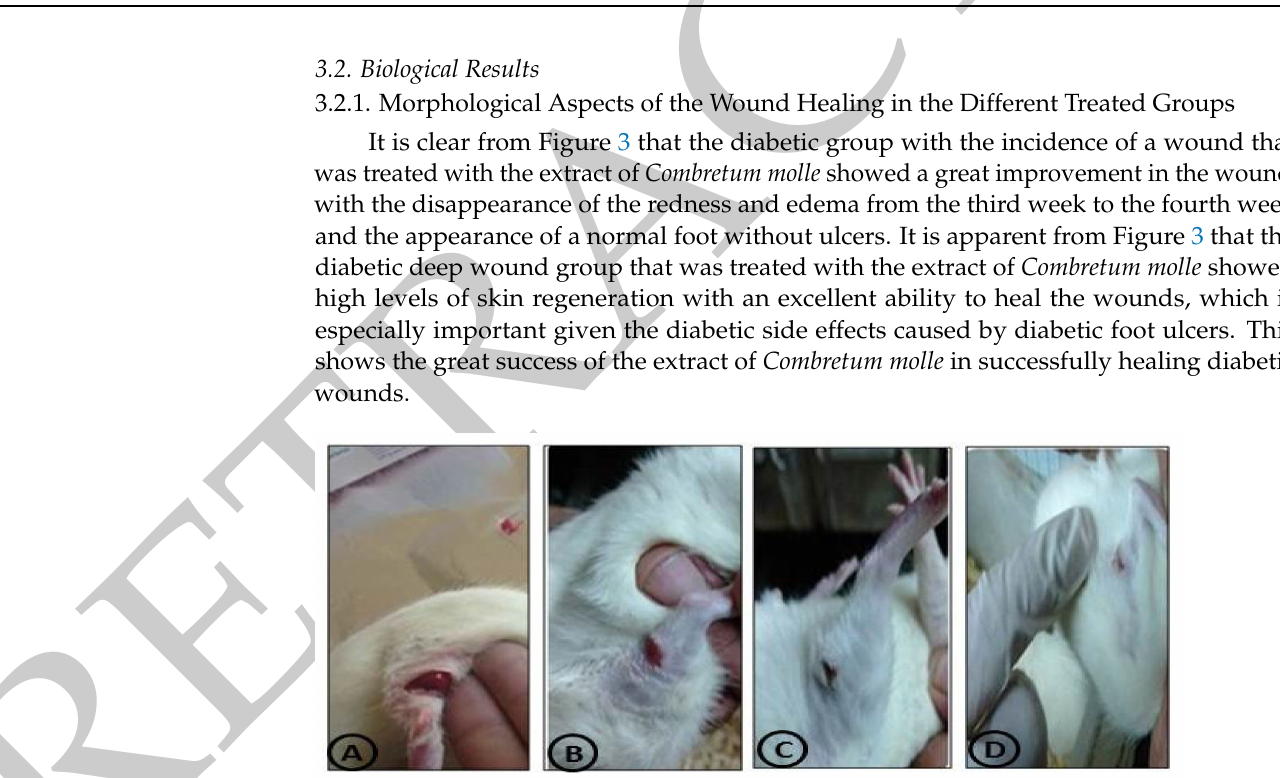
Figure 3. Variations in live sections of the wound healing model and the rats treated with the C. molle extract: ( A ) diabetic group with a deep wound, ( B ) diabetic group with a deep wound after 1 week of treatment with C. molle , ( C ) diabetic group with a deep wound after 2 weeks of treatment with C. molle , and ( D ) diabetic group with a deep wound after 3 weeks of treatment with C. molle